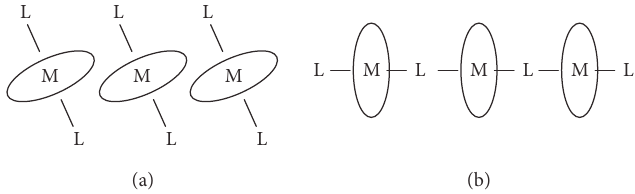
Scheme 2: (a) Slip-stacked and (b) skewered axially ligated MPc